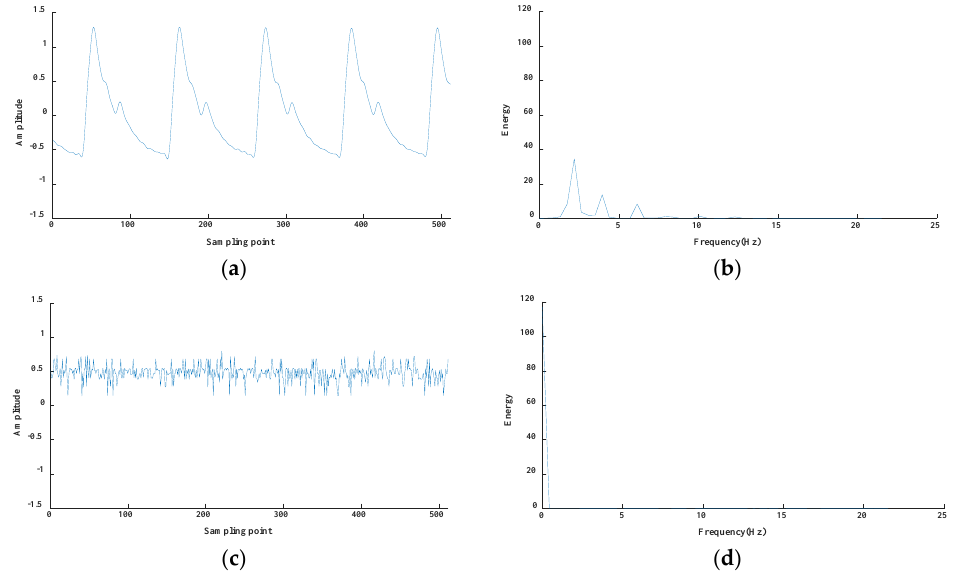
Figure 4. Signals and their spectra: ( a ) time domain diagram of valid pulse wave signal; ( b ) frequency domain diagram of valid pulse wave signal; ( c ) time domain diagram of noise signal; ( d ) frequency domain diagram of noise signal.